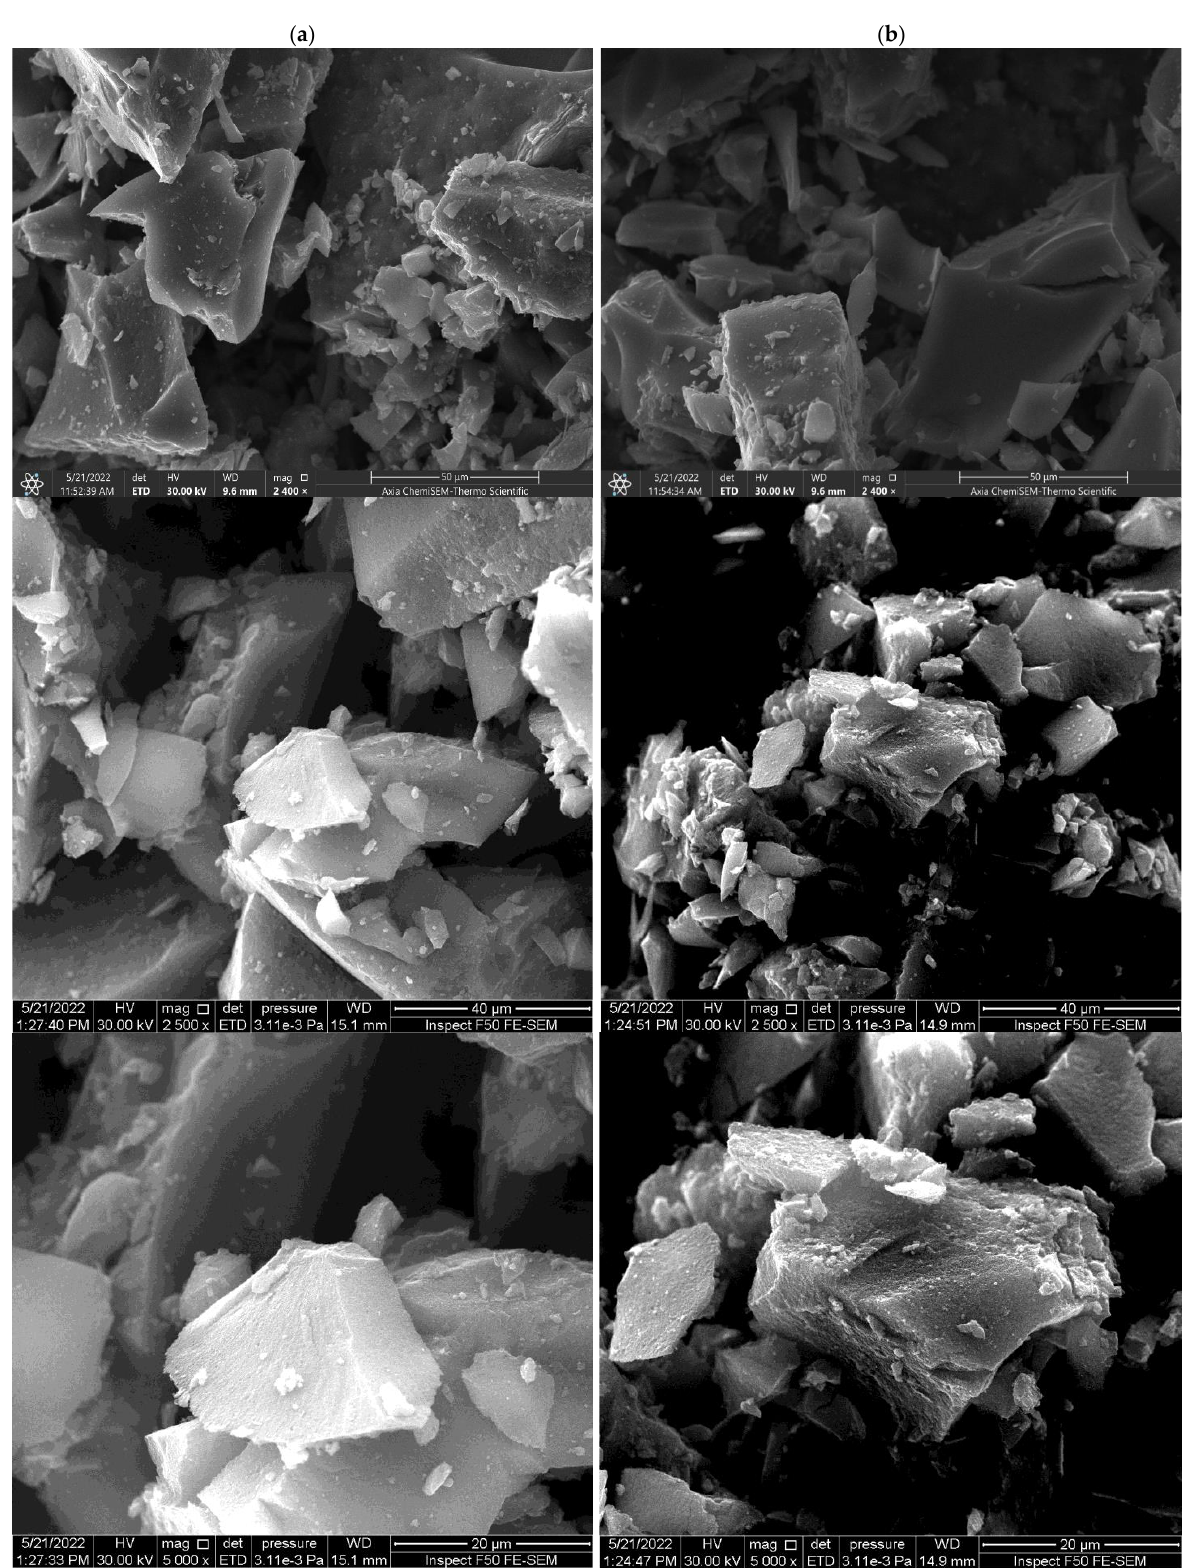
Figure 2. SEM images at various sizes of ( a ) net TiO 2 and ( b ) 5 wt% N-doped TiO 2